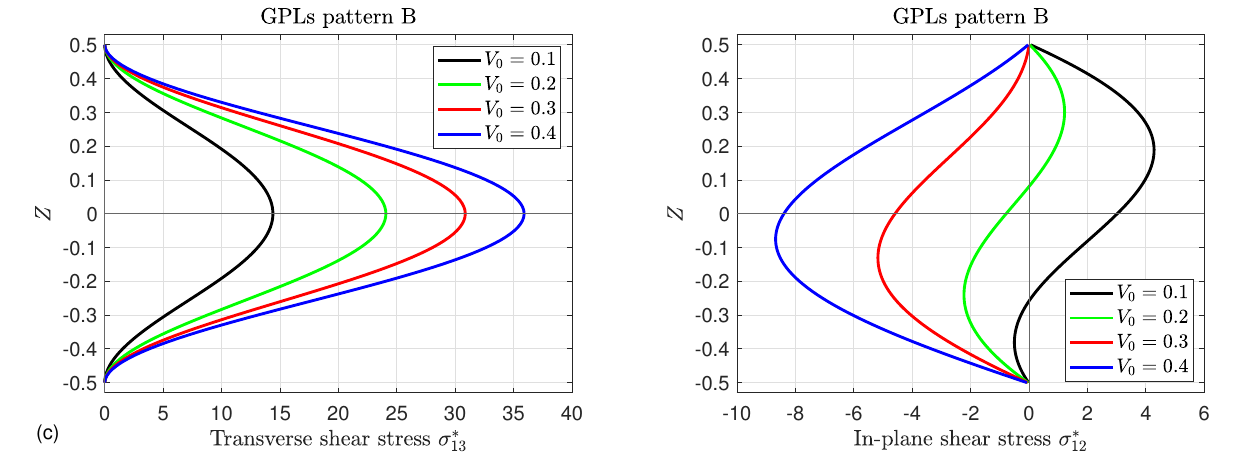
Figure 14. Influence of the applied electric voltage V 0 on ( a ) the central deflection W ∗ , ( b ) the normal stress σ ∗ , ( c ) the transverse shear stress σ ∗ 11 nanocomposite piezoelectric square